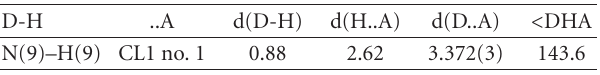
Table 8: Bond lengths ( ˚A) and angles ( ◦ ) related to the hydrogen bonding for [Pt(mpETSC)Cl].